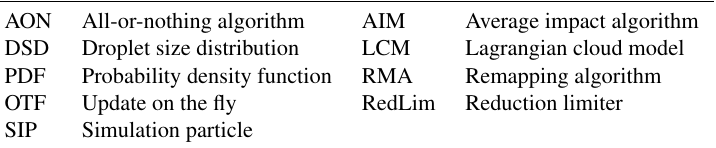
second moment of droplet mass distribution (radar reflectivity)